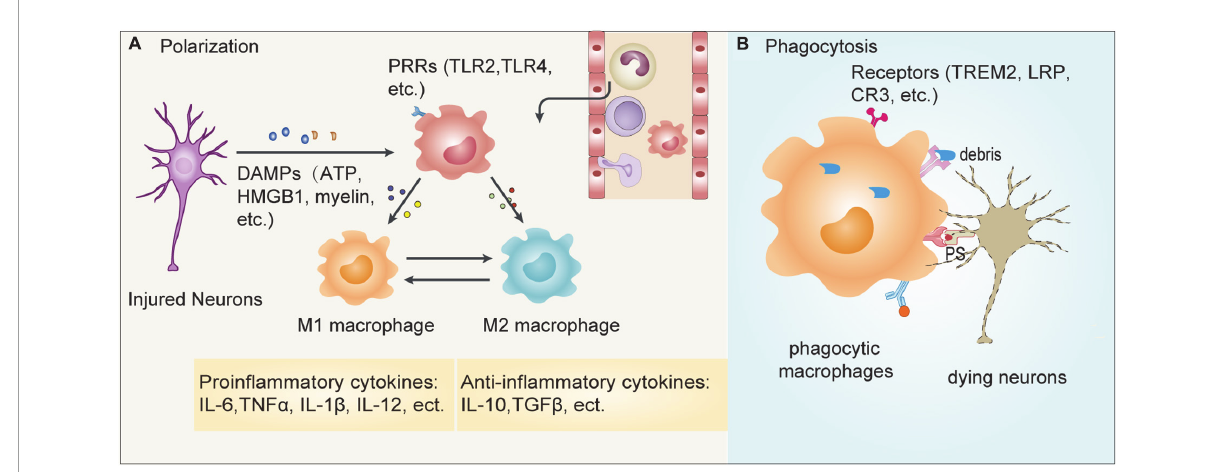
FIGURE3 Responses of MMs after ischemic stroke. Cerebral ischemia leads to the release of many inflammatory mediators which contributes to the recruitment of peripheral immune cells into the infarct brain. (A) The dying/dead neurons release damage-associated molecular patterns (DAMPs) such as ATP, HMGB1, myelin, etc., which can be recognized by pattern recognition receptors (PRRs) such as TLR2 and TLR4 expressed on MMs. The activated macrophages can then polarize into pro-inflammatory M1 or anti-inflammatory M2 cells. (B) In addition, macrophages can also recognize phosphatidylserine (PS) expressed on apoptotic neurons or myelin debris released from injured neurons, which is mediated by some specific receptors including TREM2, lipoprotein receptor-related protein LRP and complement receptor CR3, leading to phagocytosis. These two events coordinately regulate the outcome of ischemic